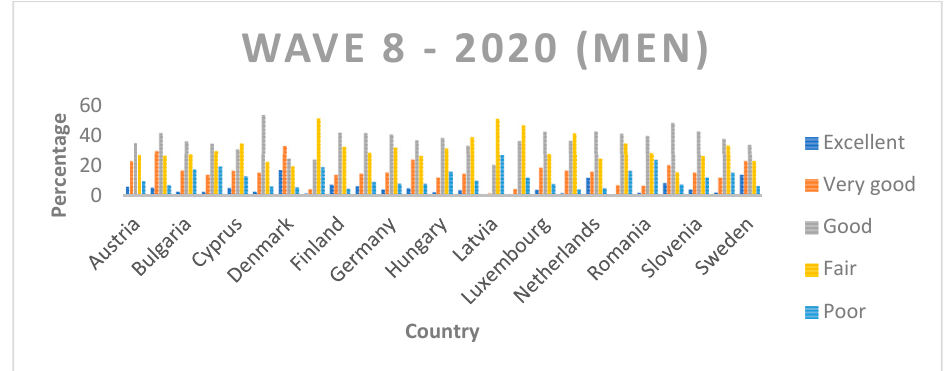
Figure A4. Distribution of women in Wave 4 (2010). Source: Authors’ elaboration based on SHARE (2021).